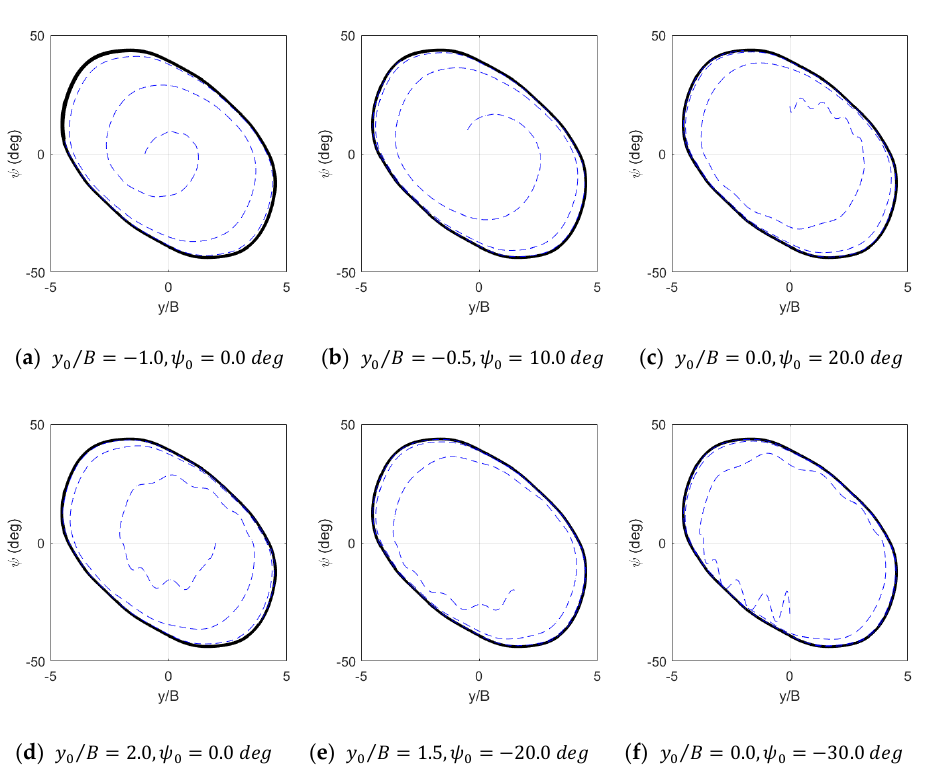
Figure 5. Phase trajectories of the towed vessel with different initial conditions ( Fn = 0.145, L T / L = 1.0 )